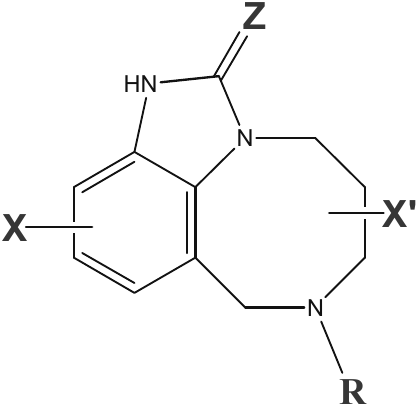
Figure 1. General structure of TIBO derivatives (X, X’, Z and R: